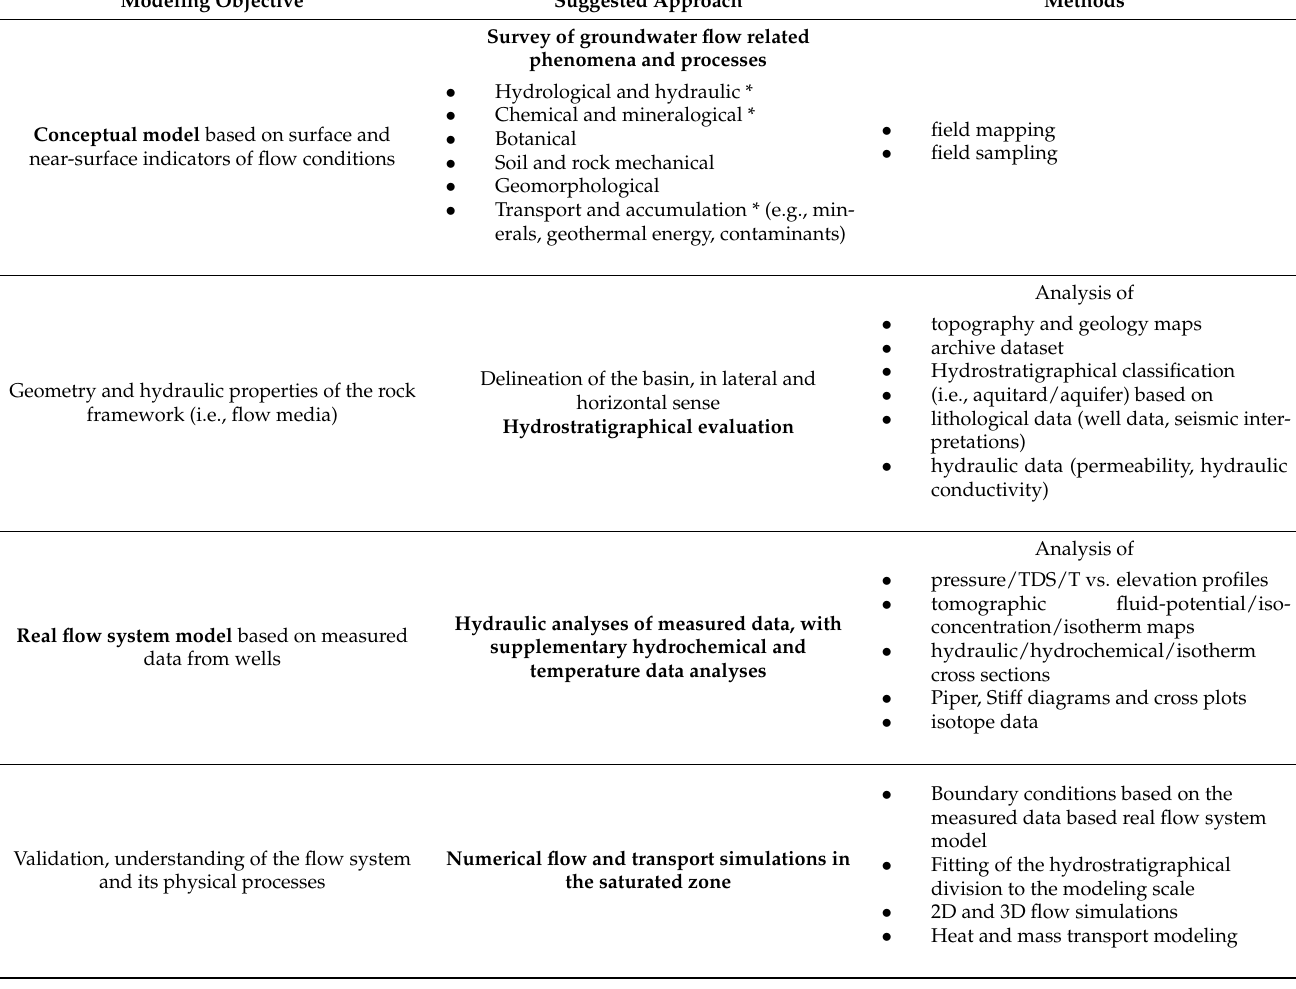
Table 3. Numerical modeling of the vadose zone combined with environmental tracers.